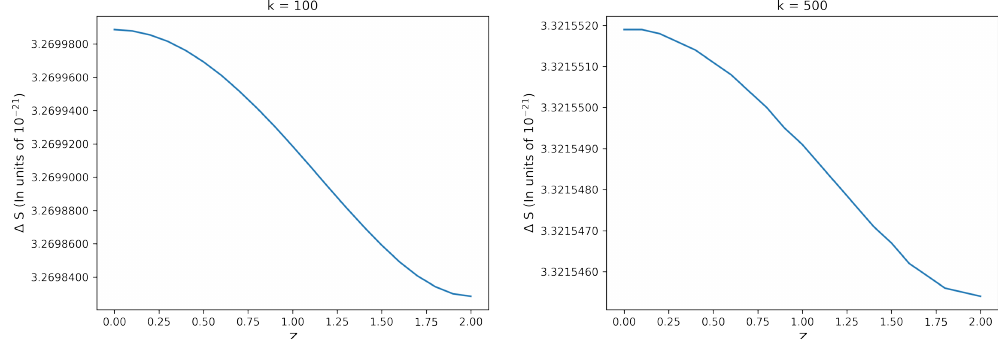
Figure 6 . The change of von Neumann entropy with same mass m a = m b = m . We use the kinematics Gm 2 = 10 − 6 , bm = 1000 , k = | ~p |